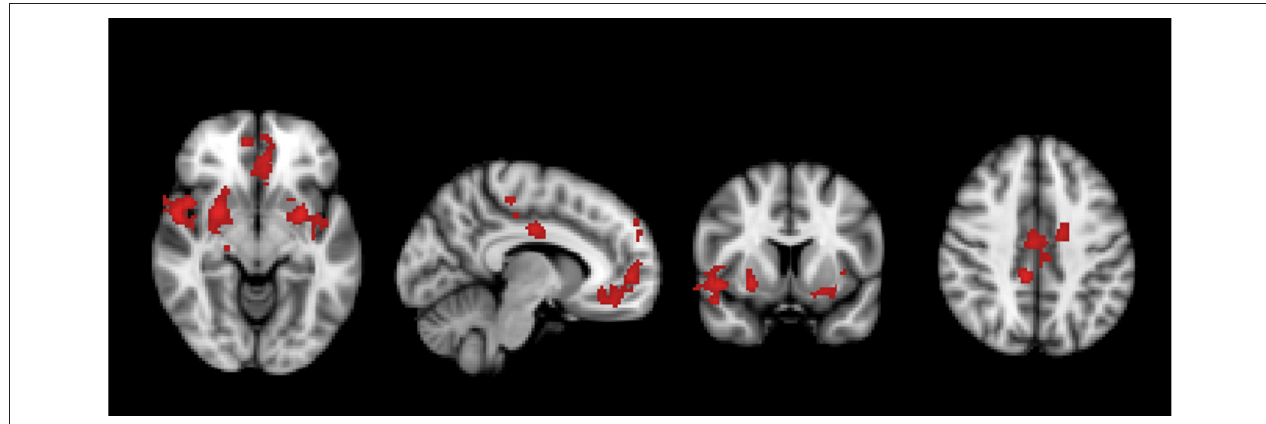
FIGURE 3 | Change in functional activation in the regions of significant group × session interaction (mean and standard-error bars) showing that after the retreat, there is a decrease in activation in the non-meditator group, and an increase in the meditator group. Cluster 1 encompasses caudate nucleus, temporal lobe, putamen and insula; cluster 2 encompasses putamen, temporal lobe and caudate nucleus; cluster 3 encompasses anterior cingulate, frontal lobe, paracingulate; cluster 4 encompasses posterior cingulate, paracingulate, anterior cingulate, callosal body, frontal lobe and juxtapositional lobule cortex.